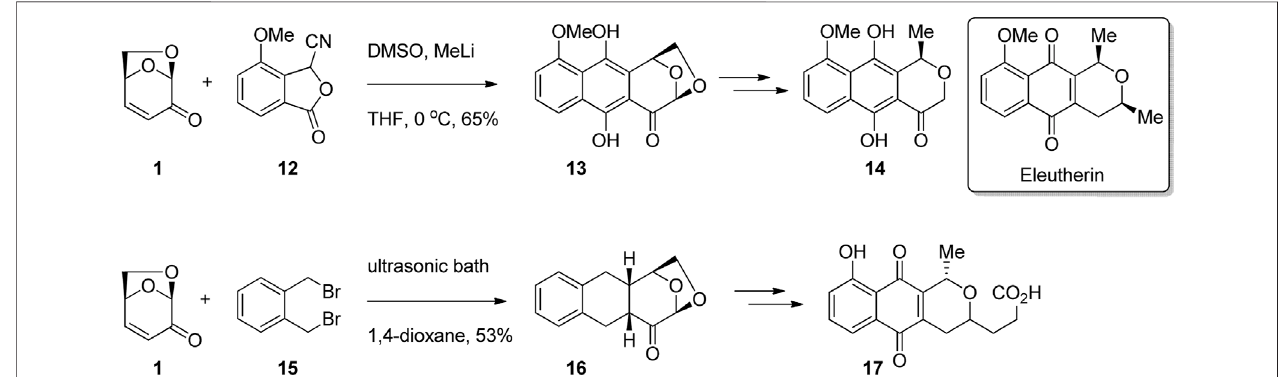
FIGURE 5 | Pyranonaphthoquinones prepared from